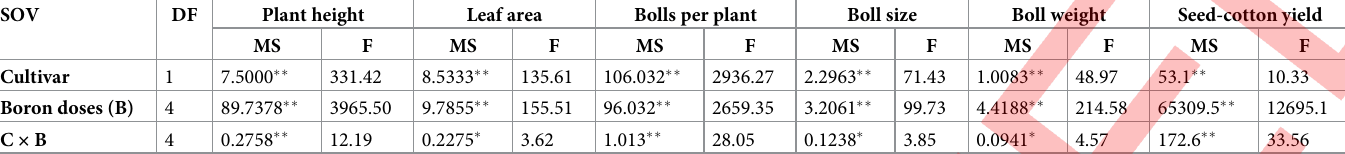
DF = degree of freedom, F = F value, MS = mean squares � = significant �� = highly Significant.